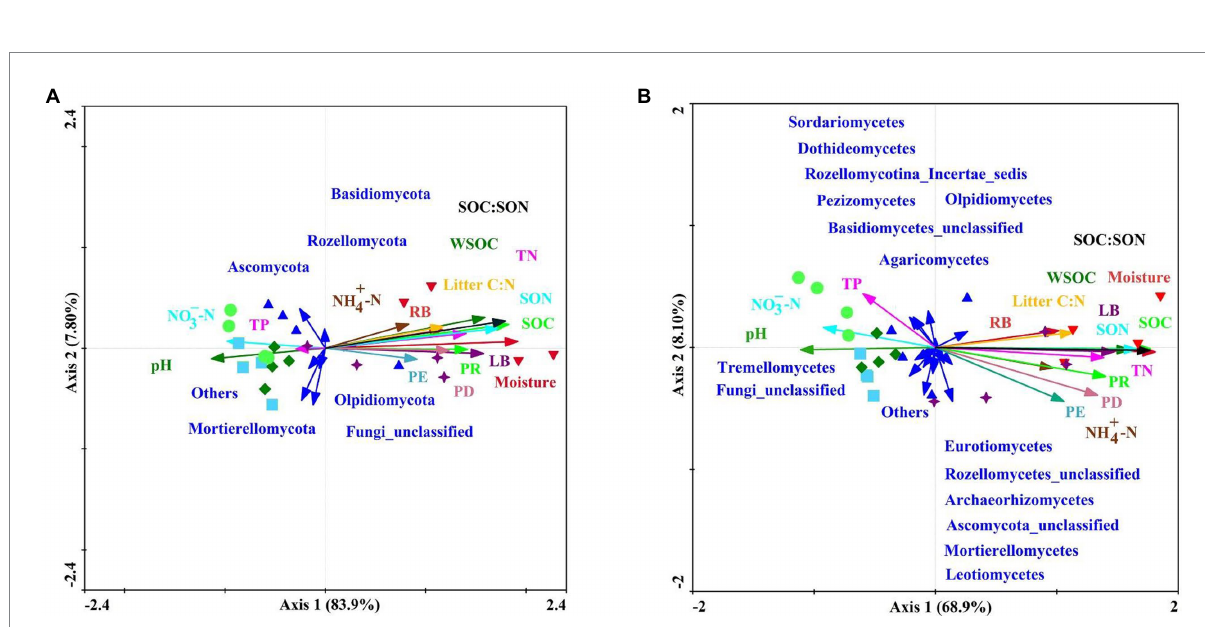
FIGURE 6 Redundancy analysis diagram illustrating the relationships between the compositions of soil fungal communities at the phylum-level (A) and class- level (B) from different sampling sites under variable environments. Explanatory variables are shown via different arrows: soil fungal community composition by solid dark blue arrows; and the environmental variables by colored arrows: Plant species richness (PR), plant species diversity (PD), plant species evenness (PE), litter biomass (LB), root biomass (RB), litter C:N, soil moisture, pH, soil organic carbon (SOC), soil water-soluble organic carbon (WSOC), total nitrogen (TN), soil organic nitrogen (SON), ammonium nitrogen (NH 4+ -N), nitrate nitrogen (NO 3 − -N), total phosphorus (TP), available phosphorus (AP), and SOC:SON. Red circles represent farmland (S1) soil; dark blue upward triangles represent pioneer weed (S2) soil; dark green diamonds represent herbage (S3) soil; yellow squares represent shrub (S4) soil; dark purple stars represent early forest (S5) soil; and red downward triangles represent climax forest